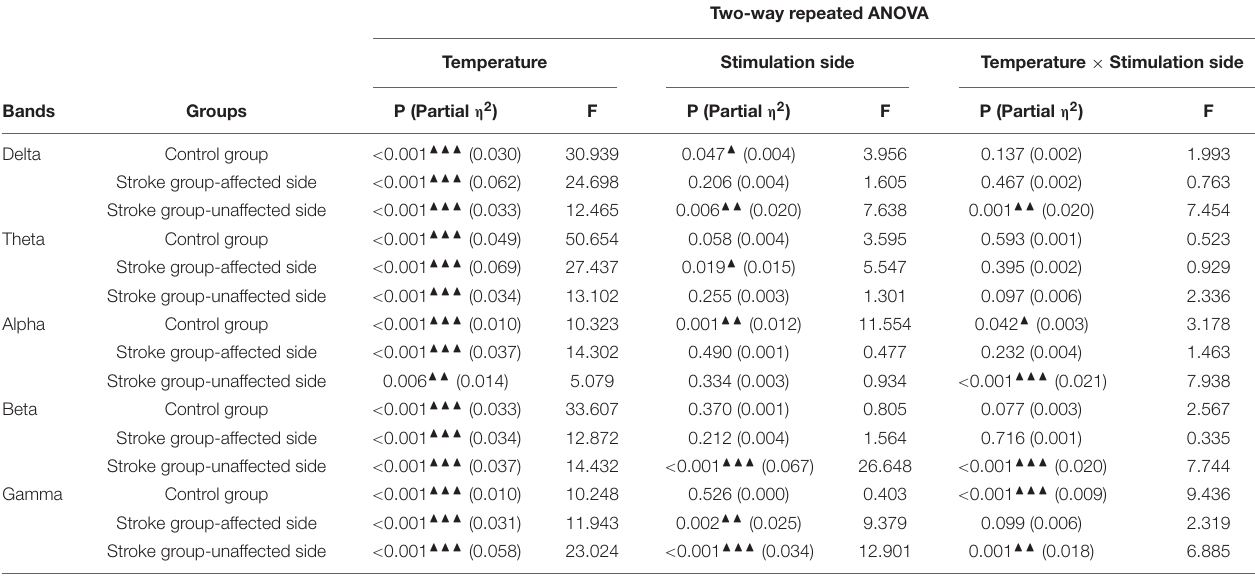
TABLE 2 | Comparisons on the whole brain relative spectral power on each EEG frequency